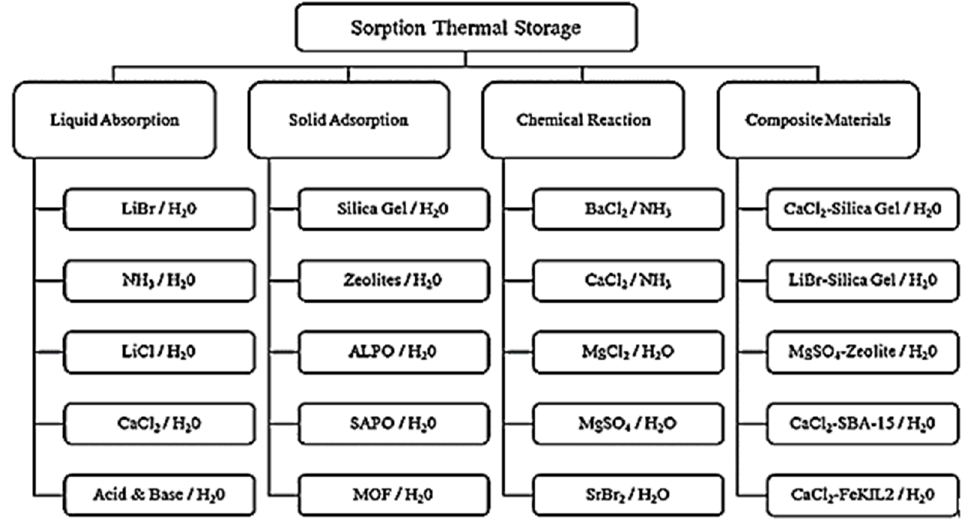
Figure 2. Sorption reactions and materials [10].